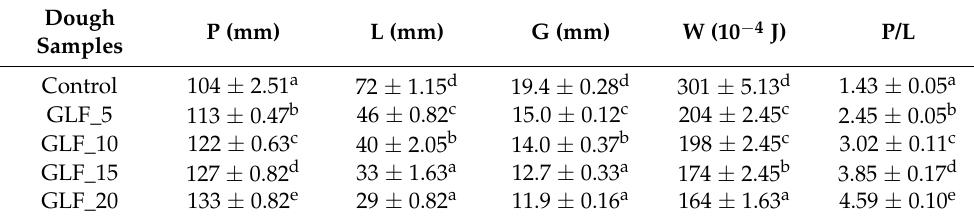
Table 2. Alveograph parameters of the dough samples with different levels of GLF